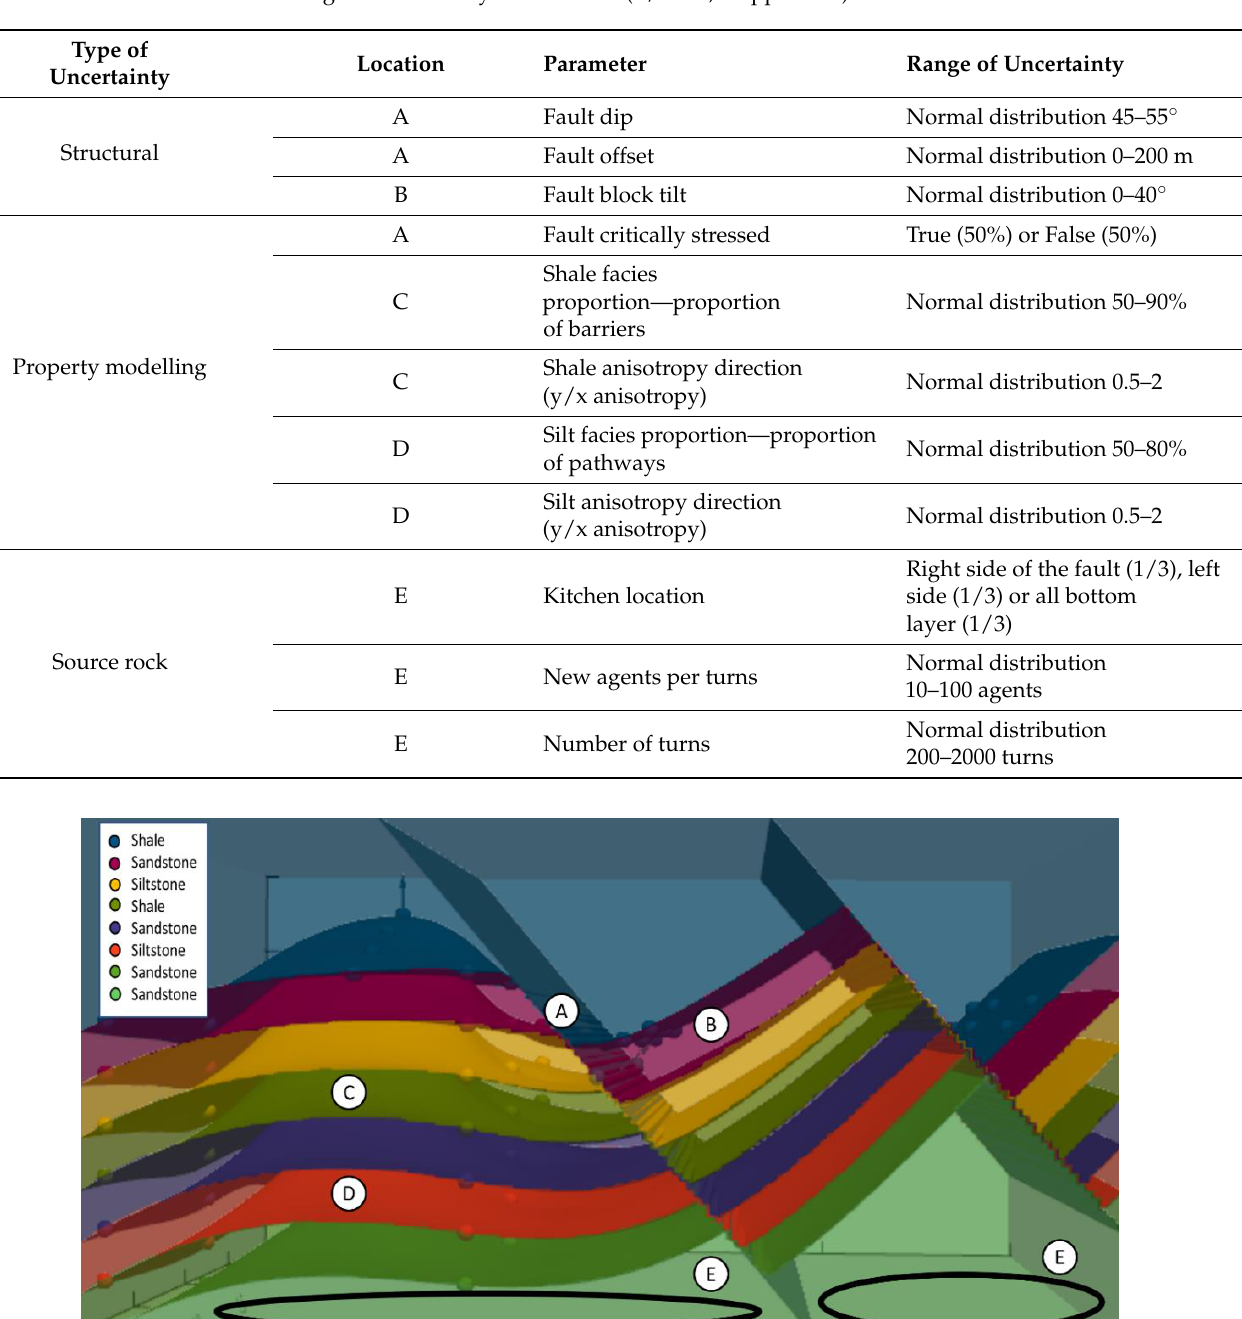
Table 1. Uncertain parameters related to either the structural modelling, the property modelling, or the initiation of an agent (related to the source rock), as seen in Figure 6. To each uncertain parameter, a range of uncertainty is associated (+/ − 2 σ , if applicable).